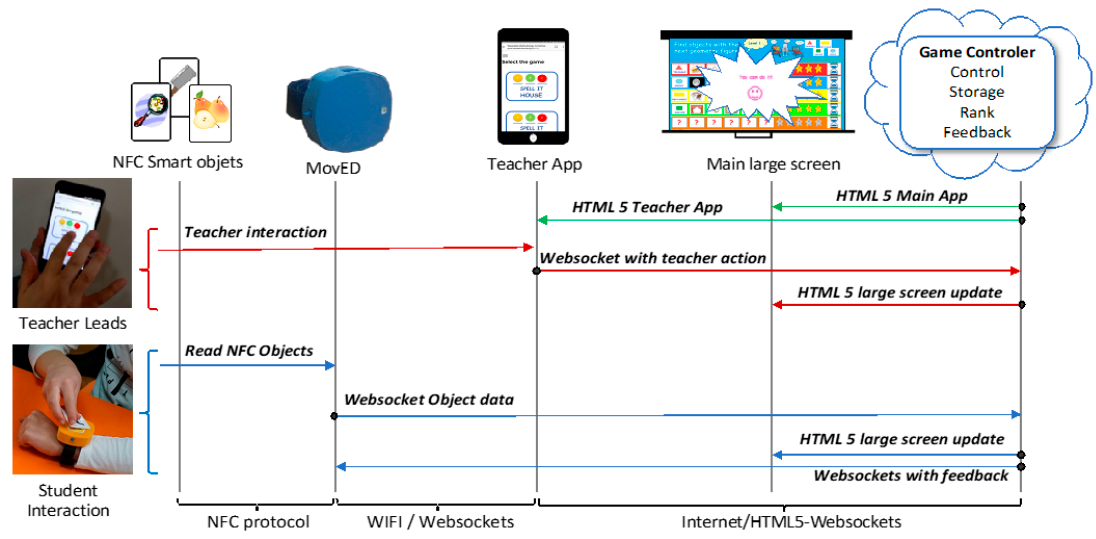
Figure 7. Flow of information that the di ff erent components of the WIoTED